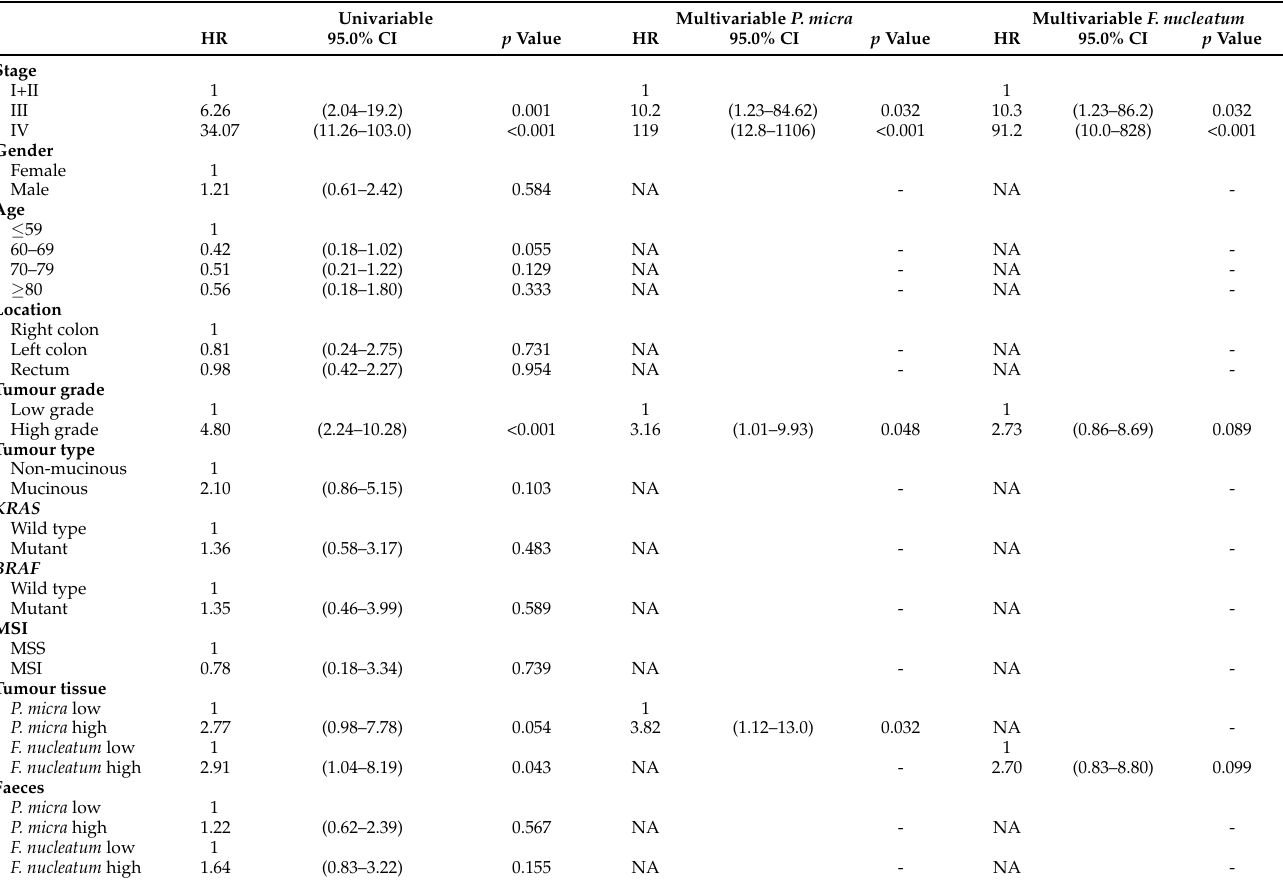
Table 4. 5-year survival uni- and multi-variable Cox analyses. The multivariable analyses were performed separately for P. micra and F. nucleatum